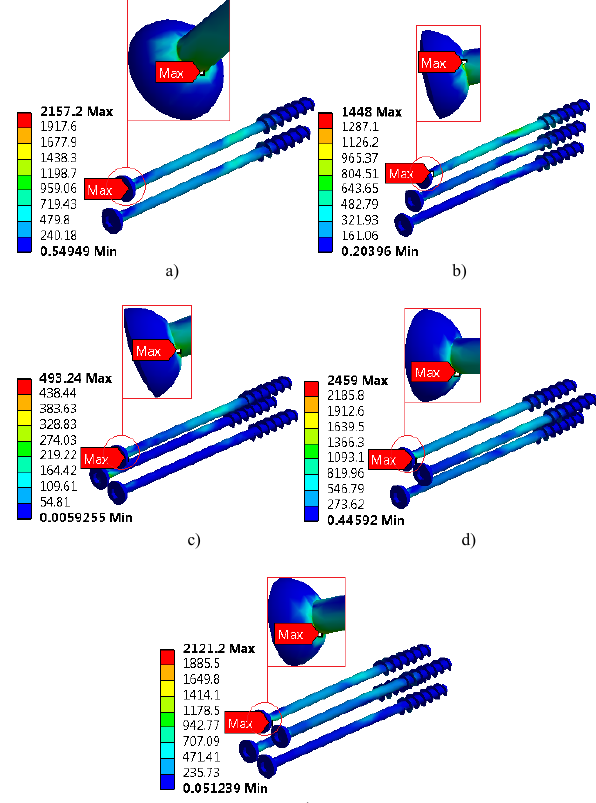
Figure 11. Stress distribution occurring in the screws under axial loading: (a) dual parallel, (b) triple parallel, (c) triangle, (d) inverted triangle, and (e)